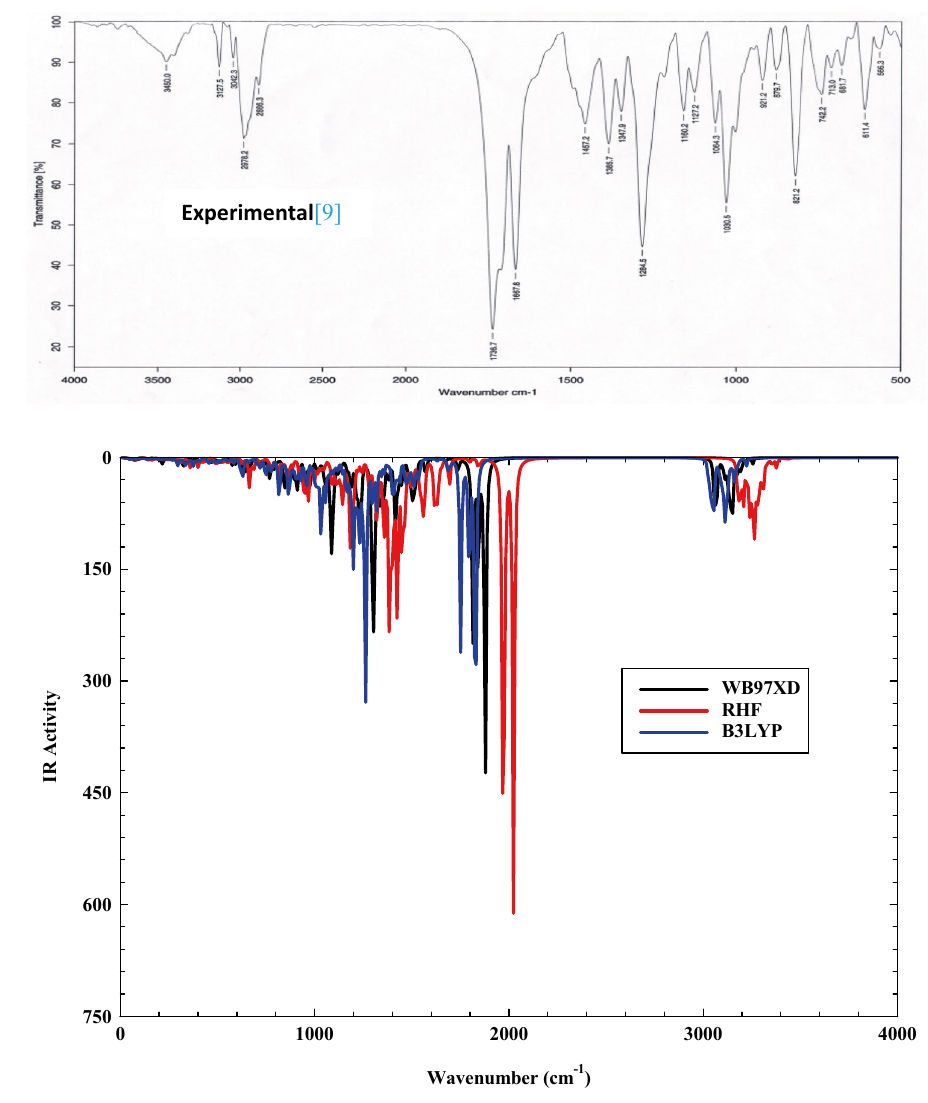
Fig. 5 Experimental data [9] and calculated infrared spectra of andirobin with B3LYP, wB97XD and RHF